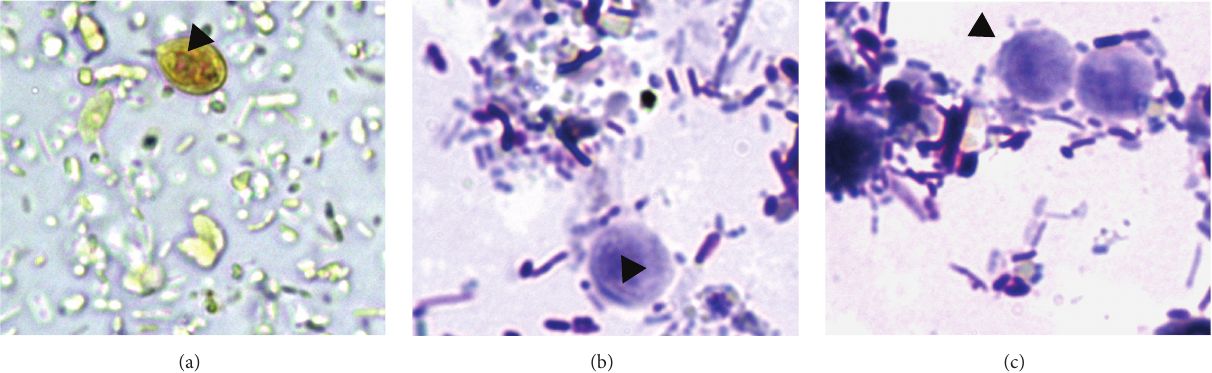
Figure 4: Drop-shaped unidentified elements in fecal smears stained with Lugol’s solution (a) and Giemsa stain (b-c). Arrow heads in (a) indicate an internal oval structure (400x). Arrow heads in (b) indicate a curved linear structure (1000x). Arrow heads in (c) indicate an undulated portion of the surface